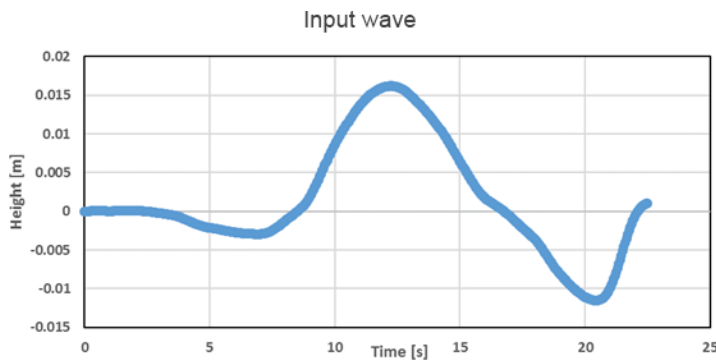
Figure A11. Prescribed input wave for the left boundary condition, defined from t = 0 to t = 22 . 5s.